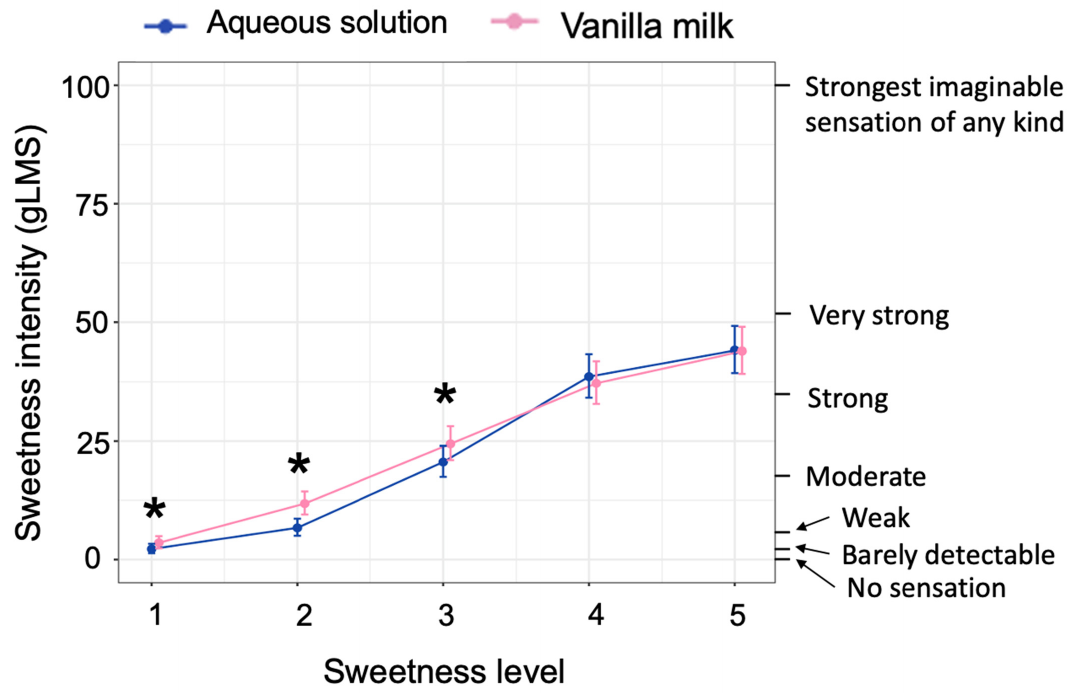
Figure 5. Average back-transformed ratings of sweetness intensity made using the general Labeled Magnitude Scale (gLMS). Data are separated by stimulus, averaged across other conditions (blue symbols for aqueous solutions, pink symbols for vanilla milk). * indicates a significant difference in rated intensity between stimuli at a particular concentration-step ( p < 0.05, according to Bonferroni- corrected post hoc contrasts). Note that back-transformed values at the lowest concentration differ very little, but the Box-Cox transformed values ( λ = 0.47) on which analyses were conducted magnify differences for very low values. Error bars represent 95% confidence intervals.